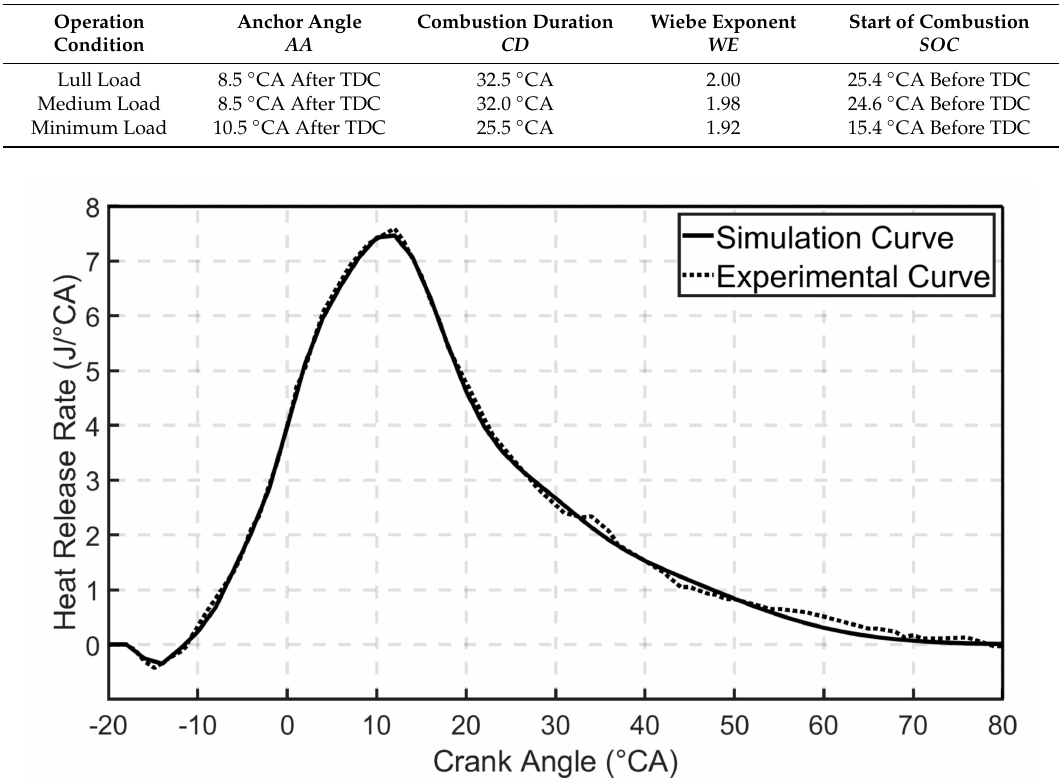
Table 14. Parameter settings of the engine combustion model.